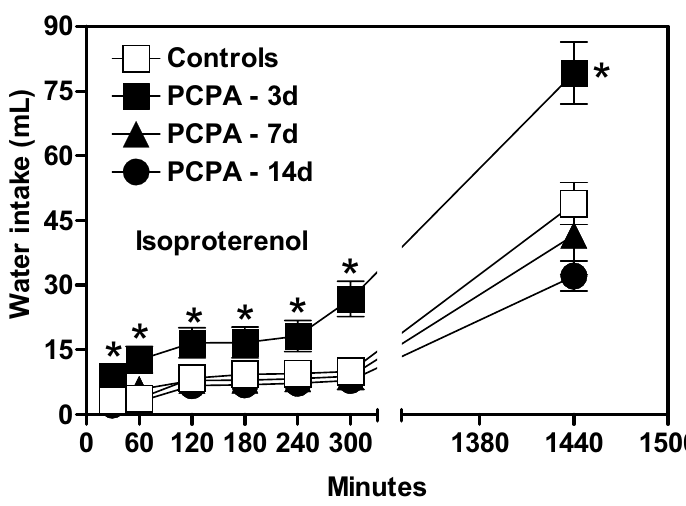
Fig. 5 – Chronic effect of treatment with p-chlorophenylalanine (PCPA, 300 mg/kg, ip , for 2 days), 3, 7 and 14 days after the first injection, on the dipsogenic responseinducedaftertreatmentwithisoproterenol(300 µ g/kg, sc ). Meanvalues represent cumulative water intake from 30 min up to 24 h. Data are reported as means ± SE. ∗ P < 0 . 05 compared to